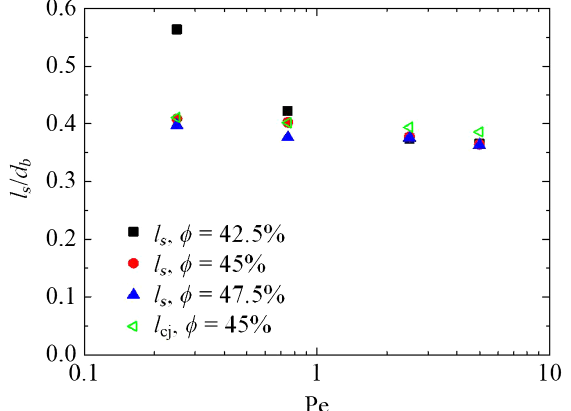
FIG. 8. The step lengths l found from the slice of Δ g ð r Þ in the s x – y plane for all simulated conditions in the shear-thinning regime (solid symbols). The cage jump lengths l for the ϕ ¼ cj 45% system (open symbols) are also shown for